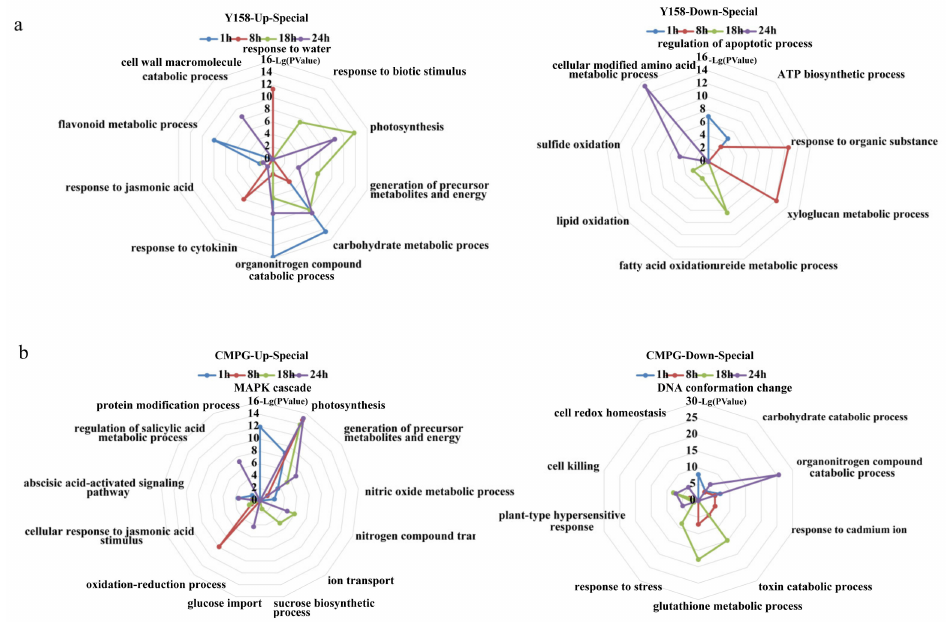
Figure 2. Specificity categories in susceptible receptor Yangmai 158 ( a ) and CMPG1-V OE ( b ) after Bgt infection. Upregulated and downregulated DEGs from 1 hai to 24 hai were selected as follows: P value < 0.05; genes with the regulation ratio log ≥ 2 or ≤− 2 were